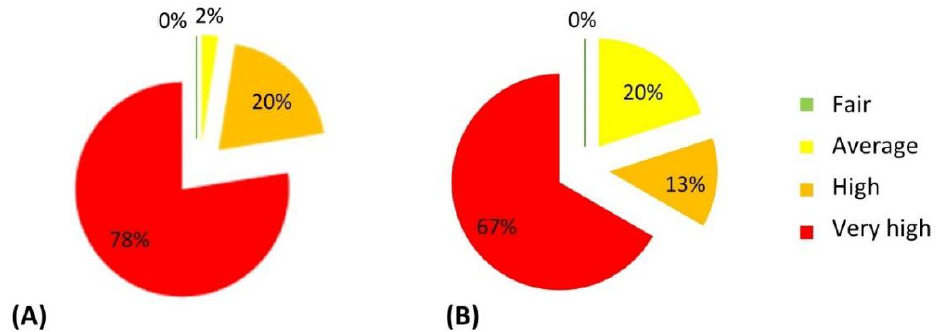
Figure 9. Degree of vulnerability of the bridge on secondary hydrographic network ( A ) and road embankment ( B ).